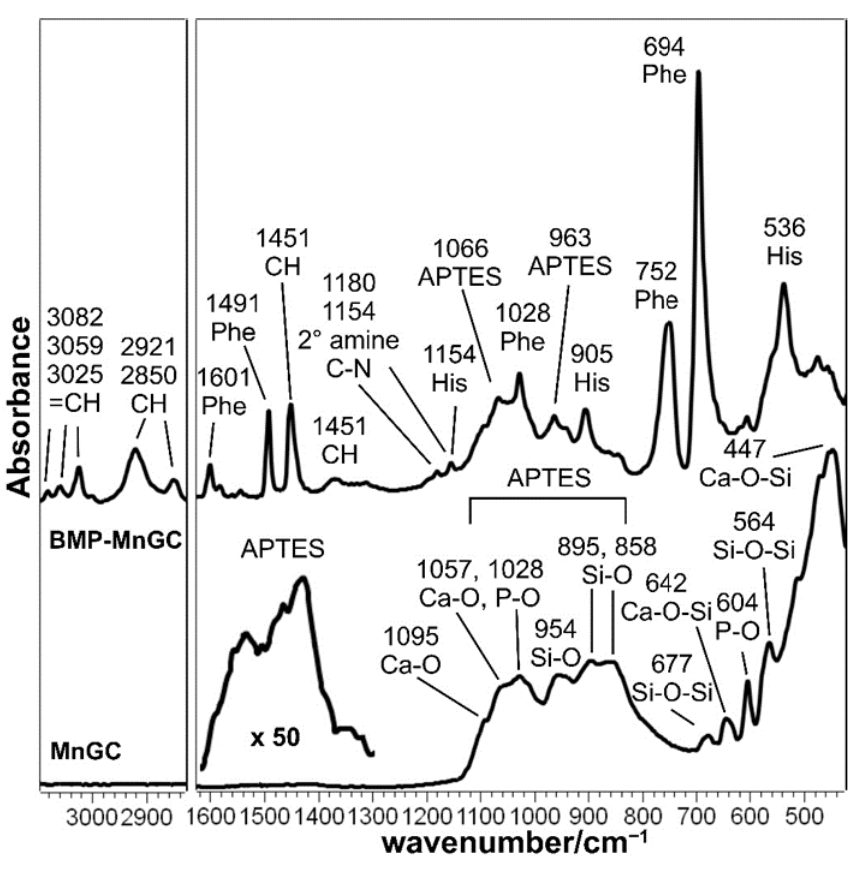
Figure 6. IR spectra of MnGC and BMP-MnGC. The spectral region between 1600 and 1300 cm − 1 of MnGC was magnified 50 times in order to better identify bands attributable to APTES.